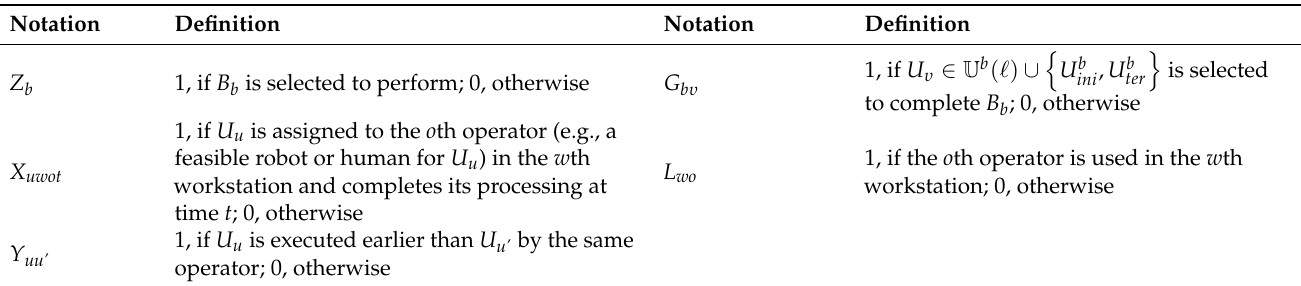
Table 3. The decision variables used in the